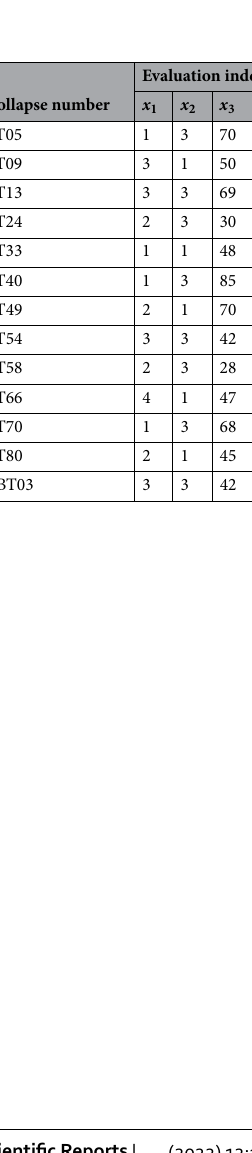
Table 3. Evaluation value of evaluation indexes.